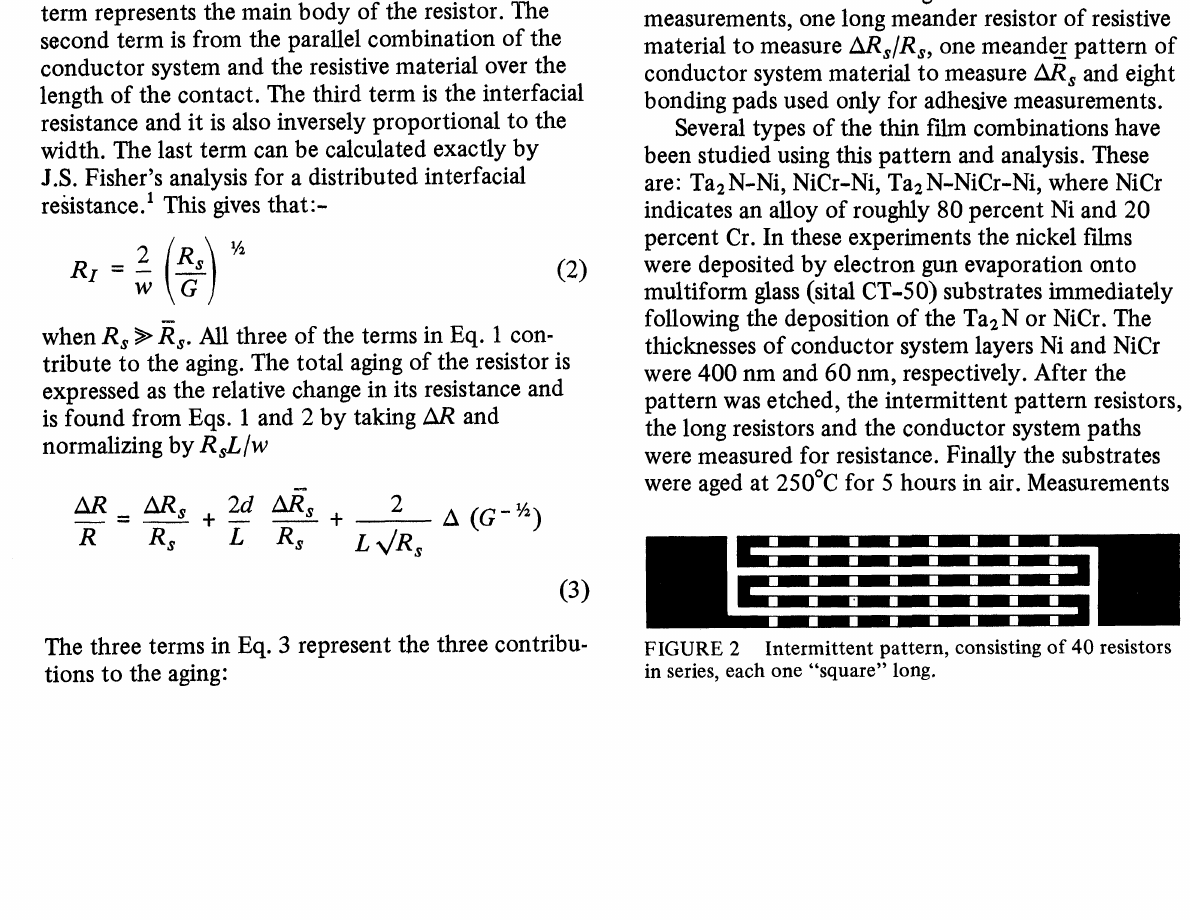
Model of a very short resistor, showing the distributed interfacial resistance.